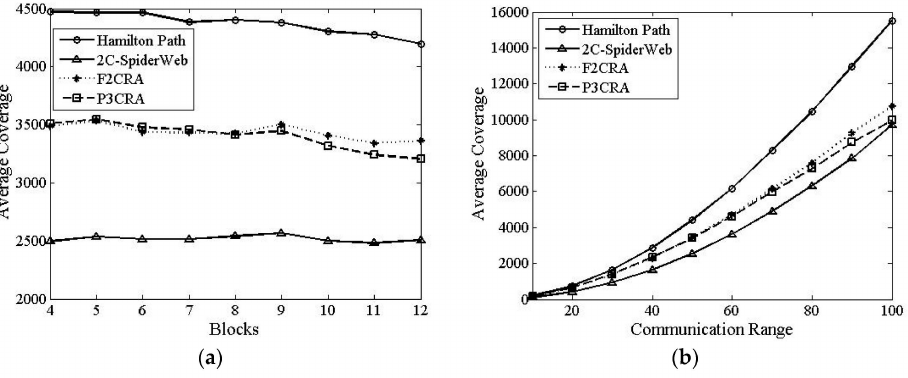
Figure 8. ( a ) The Average Coverage of Each Node vs. Segments; and ( b ) The Average Coverage of Each Node vs. Communication